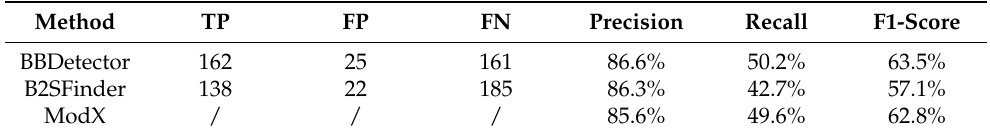
Table 3. TPL detection on nix binary